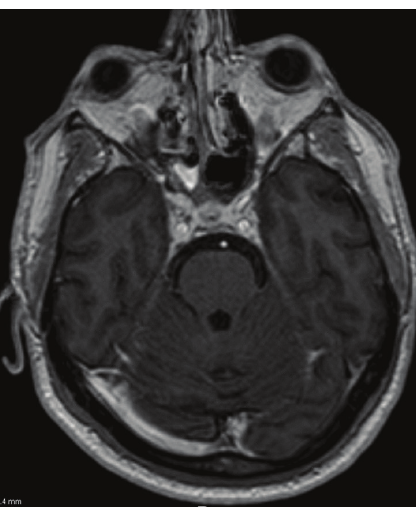
Figure3:AxialT1-weightedMRIwithgadoliniumcontrastshowing a subtotal response 6 months